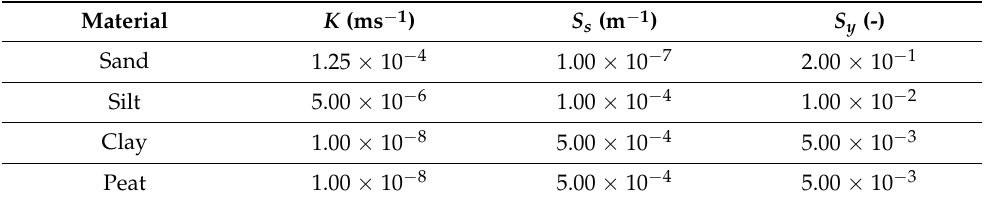
Table 1. Calibrated hydraulic parameters assigned to each material used in the model.